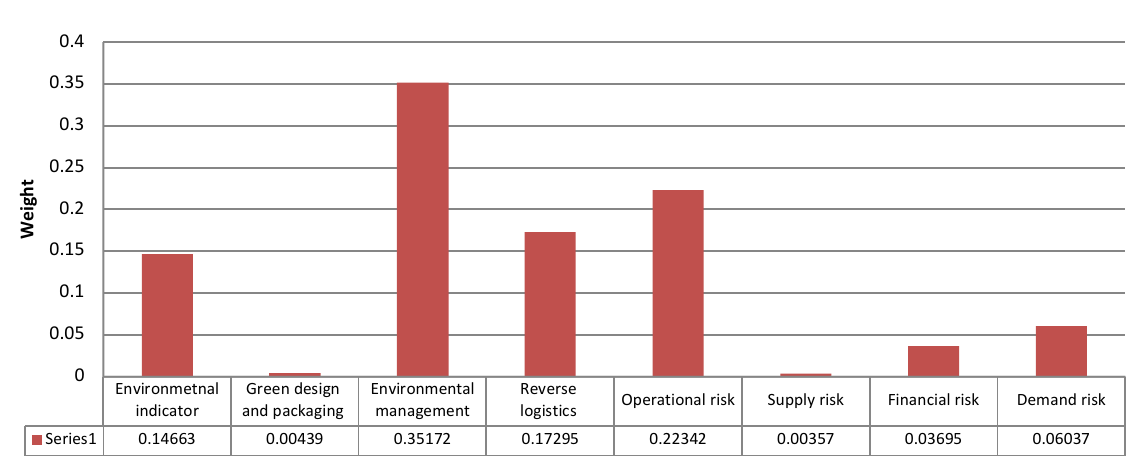
Figure 5. Ranking the GSCM criteria of condensate storage tank construction